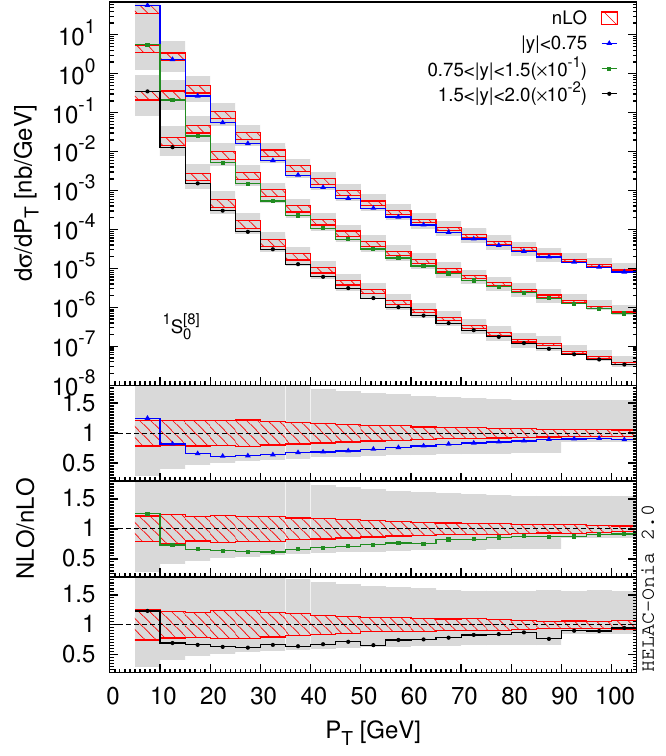
Figure 10 . Comparisons of the differential cross sections for 1 S [8] 10 (cid:0) 2 with z and the complete NLO cut ; s = m